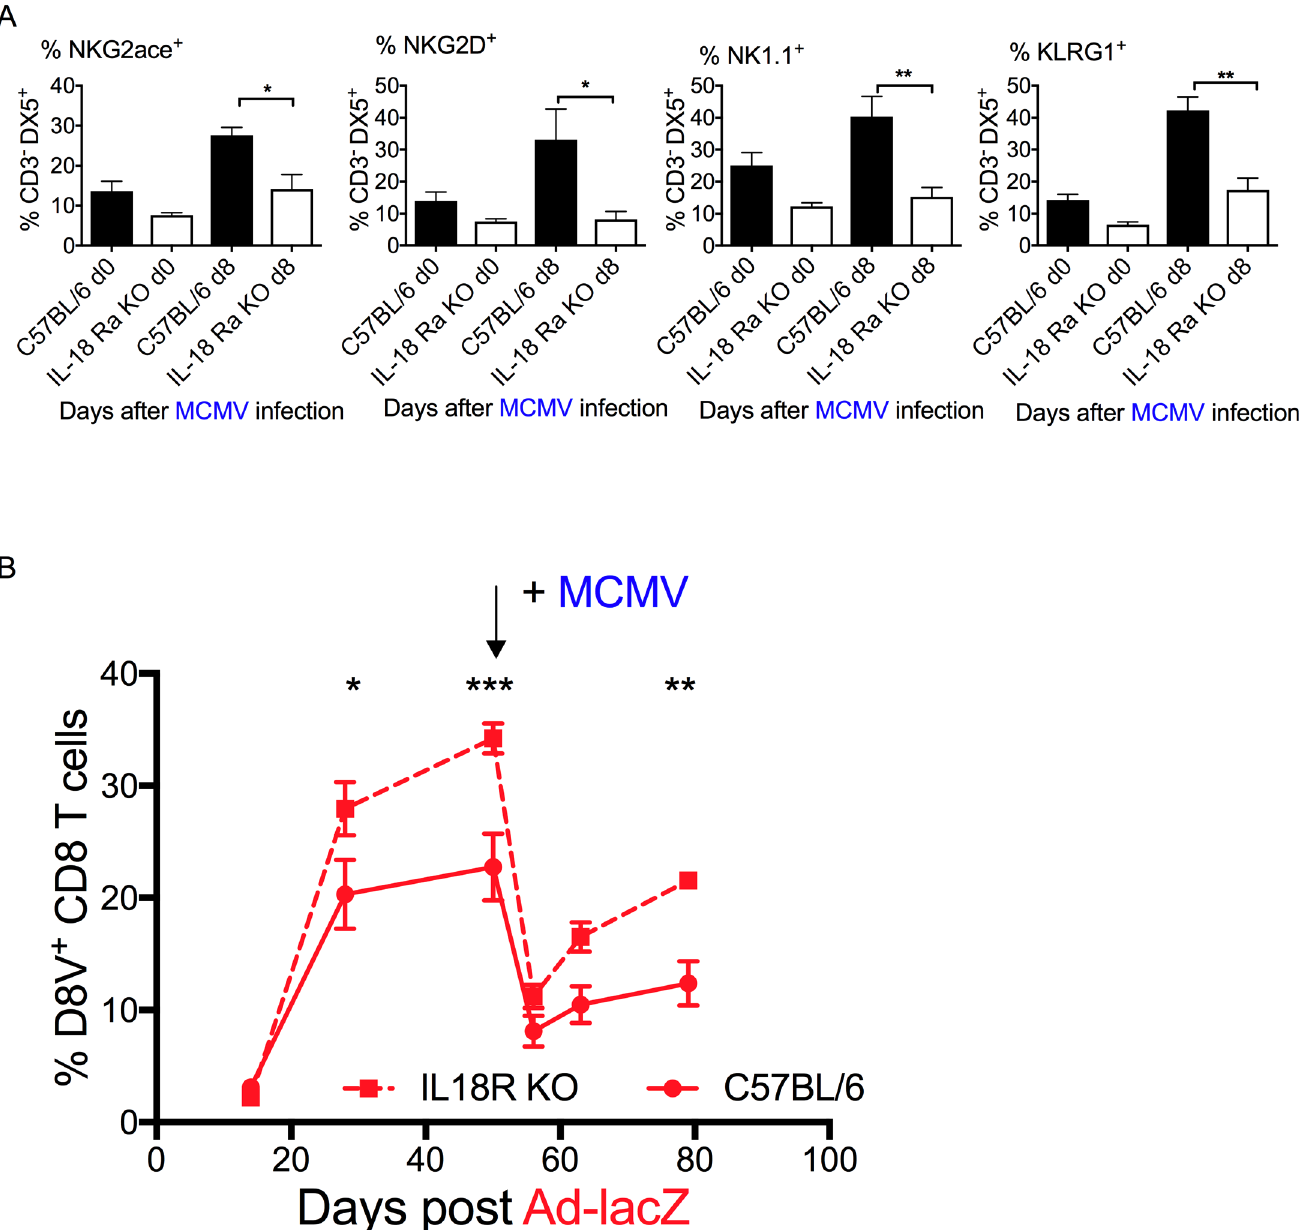
Fig 6. Effect of MCMV infection on pre-existing D8V responses in Ad-lacZ- immune IL-18KO mice. (A) NK cell activity in IL-18 mice upon MCMV infection. The levels of activation markers NKG2ace, NKG2D, NK1.1 and KLRG1 (left to right) were measured by ex vivo staining of blood after MCMV infection (N = 8–12 mice per group from 2 independent experiments). (B) IL-18RKO mice were immunized with Ad-lacZ, then 50 days later were infected with MCMV (as indicated). The levels of pre-existing D8V + CD8 T cells in the blood of IL-18R KO mice (N = 5 per group) were measured by ex vivo tetramer staining. p values were determined using one-way Anova. (cid:3) p < 0.05, (cid:3)(cid:3) p < 0.005, (cid:3)(cid:3)(cid:3) p < 0.0005. CD103 expression (S8B Fig)[16,35]. Analysis of the boosted D8V cells at the early timepoint Day 6 post-boost indicated that almost all (98.4%) of the D8V + tetramer cells were still of the effector memory phenotype, akin to the D8V + tetramer cells in long term Ad-lacZ immune (96.8%) and Ad-lacZ+MCMV (95.8%) mice and very different to the make up of the D8V